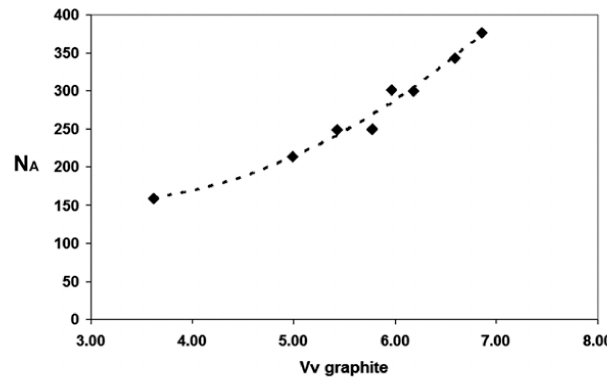
Figure 4. Relation between the graphite count number per mm 2 , N A , and its volume fraction.